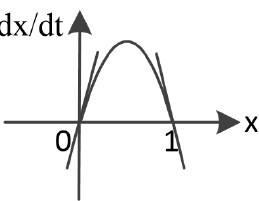
Figure 3. Sketch map of the defender’s dynamic equation.